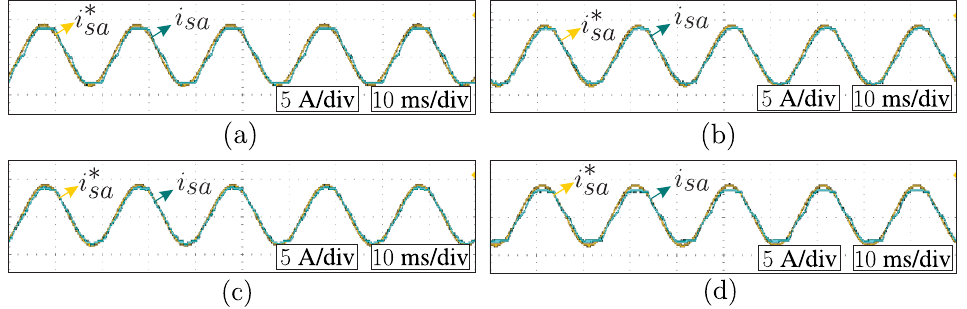
Figure 12. Gain adjustment validation, K 1 and K 2 . ( a ) K 1 = 1. ( b ) K 1 = 1000 ( c ) K 2 = 0.01. ( d ) K 2 = 100.